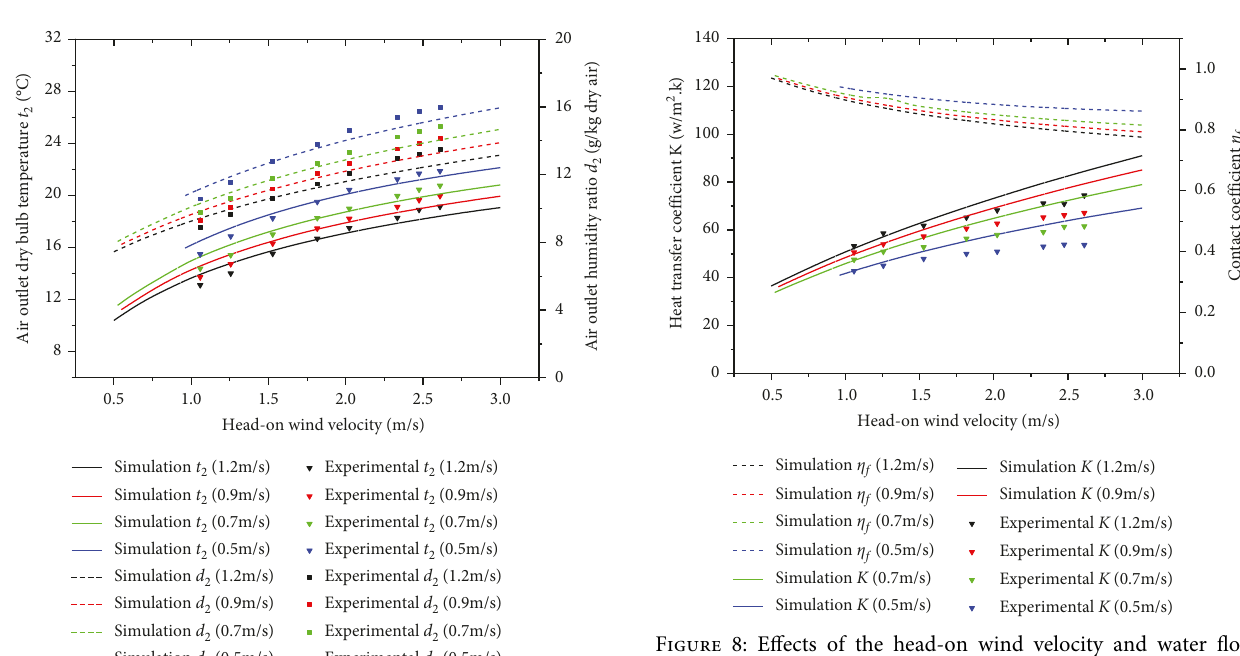
Figure 8: Effects of the head-on wind velocity and water flow velocity to heat transfer performance.